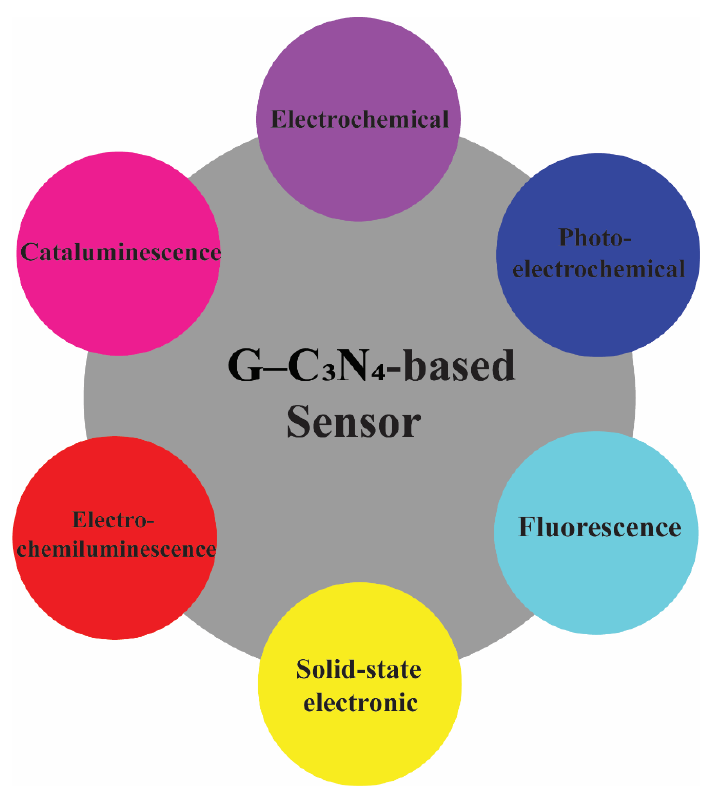
Figure 20. Different kinds of g-C 3 N 4 – metal oxide-based sensors for materials detection.